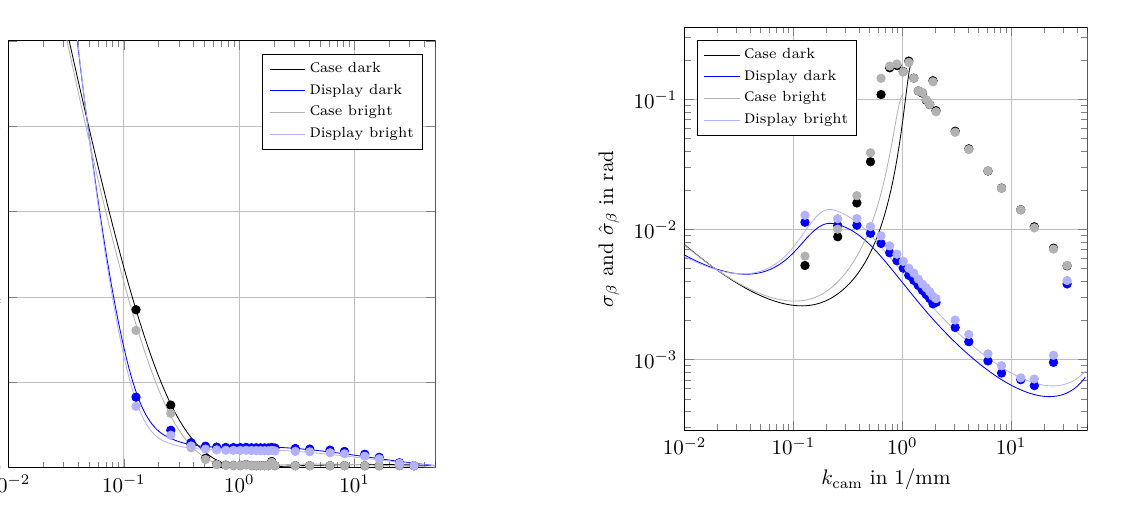
Figure 23. Comparison of the predicted measurement uncertainty (lines) and standard deviation (points) of σ α using the deflectomet- ric measurement model.